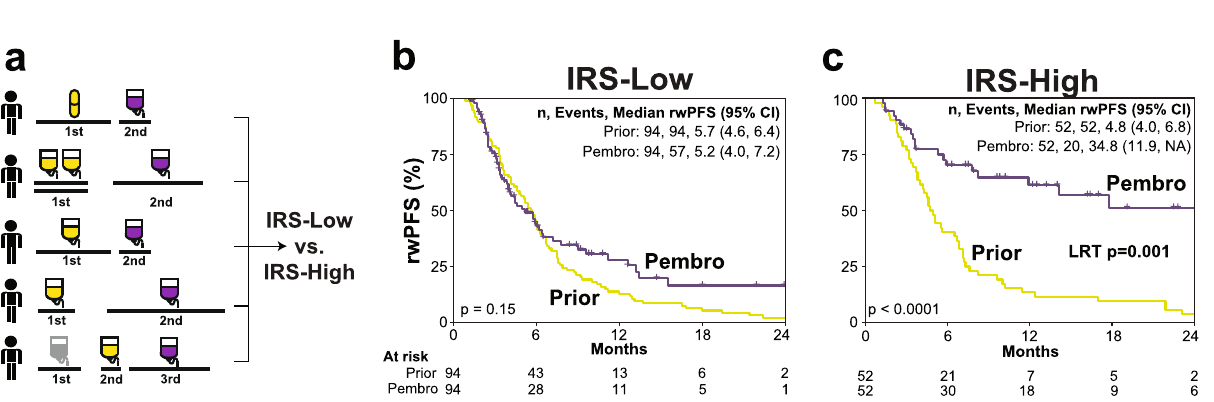
Fig. 3 Con fi rmation of the predictive nature of the immunotherapy response score (IRS) biomarker. To establish the predictive nature of the IRS model, we assessed an internal comparator in the pembrolizumab monotherapy cohort, consisting of the 146 patients who had received a prior line of systemic therapy prior to pembrolizumab monotherapy ( n = 146 individual patients). a For each patient, real-world progression-free survival (rwPFS) was determined for the line of systemic therapy immediately prior to pembrolizumab (pembro; yellow) and the pembrolizumab monotherapy line (purple), with rwPFS for each group then strati fi ed by IRS status. b Kaplan – Meier analysis of pembrolizumab monotherapy rwPFS (purple) vs. prior systemic therapy rwPFS (yellow) in the IRS-Low [L] subset of patients (log-rank p-value shown). The number ( n ) of patients, events, and median rwPFS (with 95% con fi dence intervals [CI]) for each group are shown. c Kaplan – Meier analysis of pembrolizumab monotherapy rwPFS (purple) vs. prior systemic therapy rwPFS (yellow) in the IRS-H subset of patients (log-rank p -value shown). The likelihood ratio test (LRT) p -value for interaction between pembrolizumab vs. immediately prior treatment line and IRS status (IRS-L vs. IRS-High [H]) is also